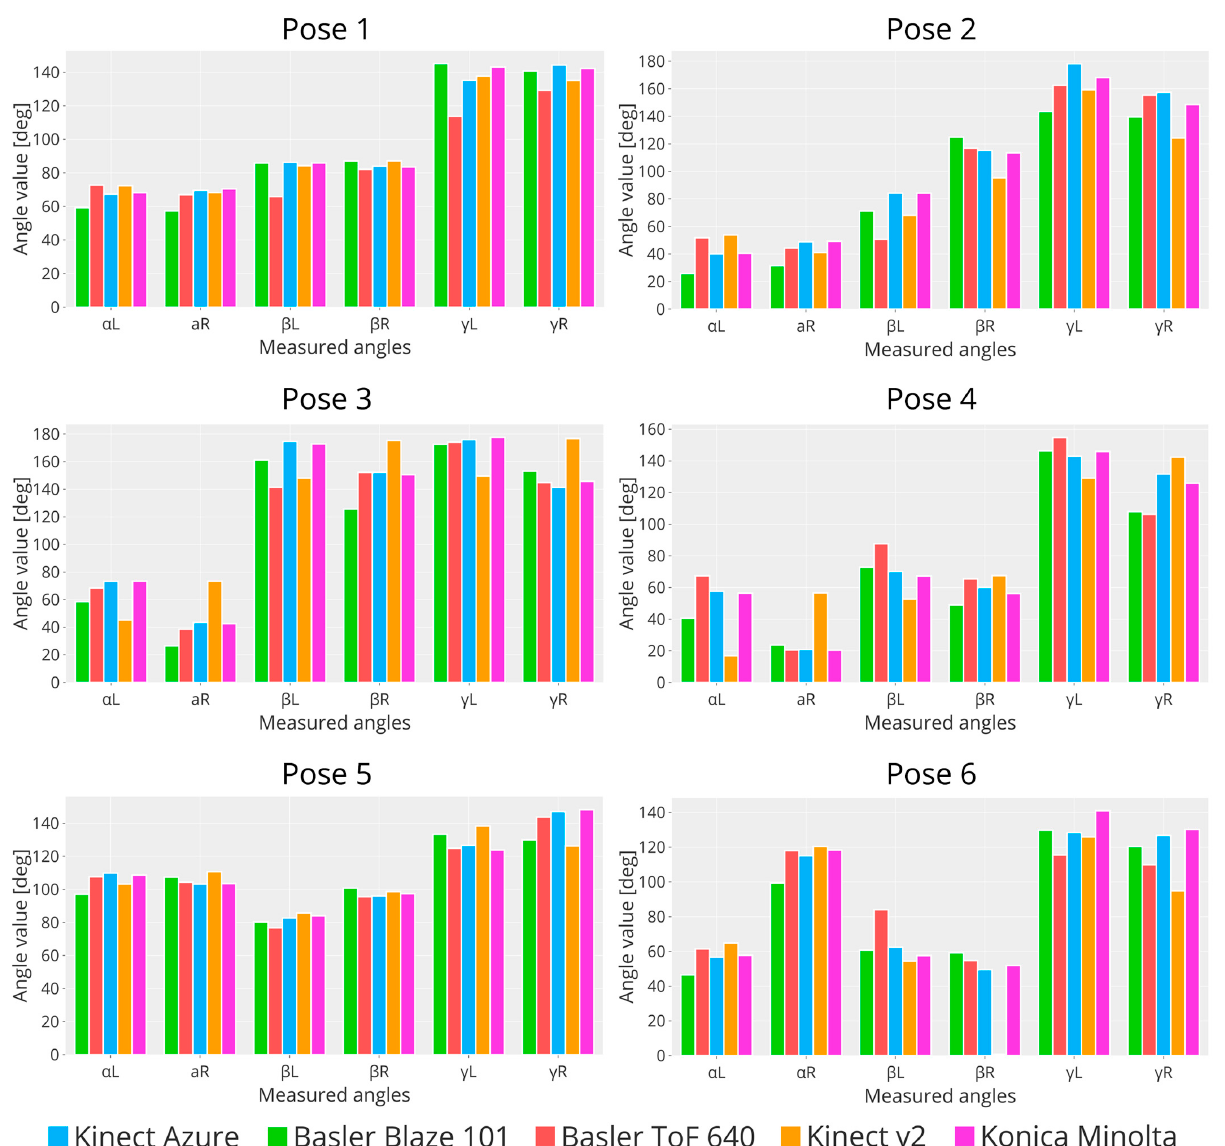
Figure 10. Graphs showing the measured angles of interest for the six poses. To better analyze the results, the differences between the resulting values and the corresponding angle measured by the Konica Minolta are shown in bar plots in Figure 11. For most configurations, the Kinect v2 measurements are noticeably different from the reference ones acquired with Konica Minolta, sometimes reaching values of more than − 30 deg (measured angle higher than reference) and more than 50 deg (measured angle lower than reference). The 𝛽 (cid:3013) angle measured by Basler ToF 640 is the most different from the reference for all configurations, achieving errors ranging from more than − 20 deg up to more than 30 deg. In comparison, Basler Blaze 101 performs better, achieving errors of − 10 deg up to 25 deg. Azure Kinect measurements are typically the same as those com- puted from Konica Minolta, with errors ranging from − 10 deg up to 12 deg, mostly occur- ring in correspondence of angles 𝛾 (cid:3013) and 𝛾 (cid:3019) . These two angles consider the arm and the hand segments, which are difficult to measure accurately since the point clouds are less dense. These tests showed that Kinect Azure’s performance in reconstructing human bod- ies is notably improved compared to Kinect v2, resulting in lower errors. It is worth noting